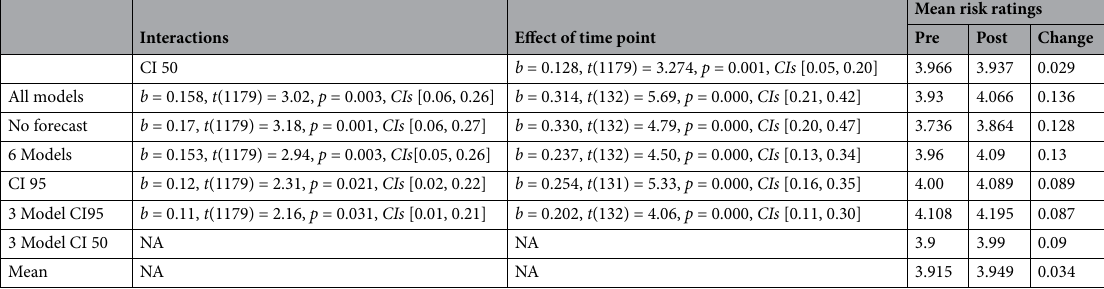
Table 1. Interactions between each visualization type and CI 50, along with the effects of time point when models were computed for each visualization type (ordered by size of the time point main effect). These results are collapsed across the